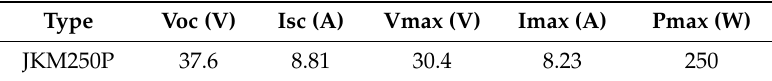
Table 2. Specifications of the PV module.